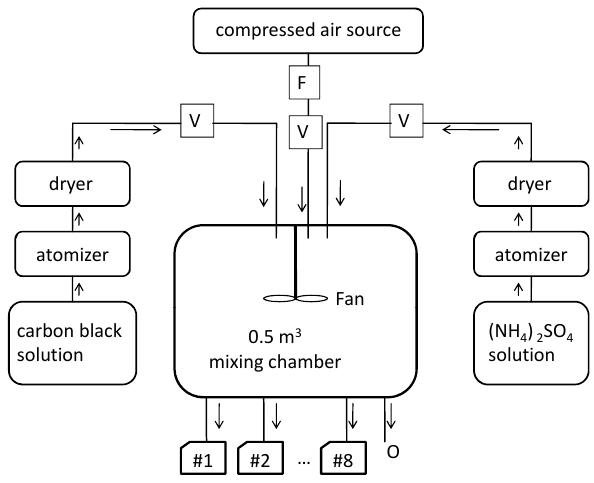
Fig. 1. Experimental setup for runs with ammonium sulfate and soot. Concentrations of ammonium sulfate and carbon black aerosols were adjustable. The aerosol was dried before entering the chamber. Direction of aerosol flow is indicated by arrows. In this diagram, F=filter, V=valve, O=overflow. Instruments were connected to output ports 1 to